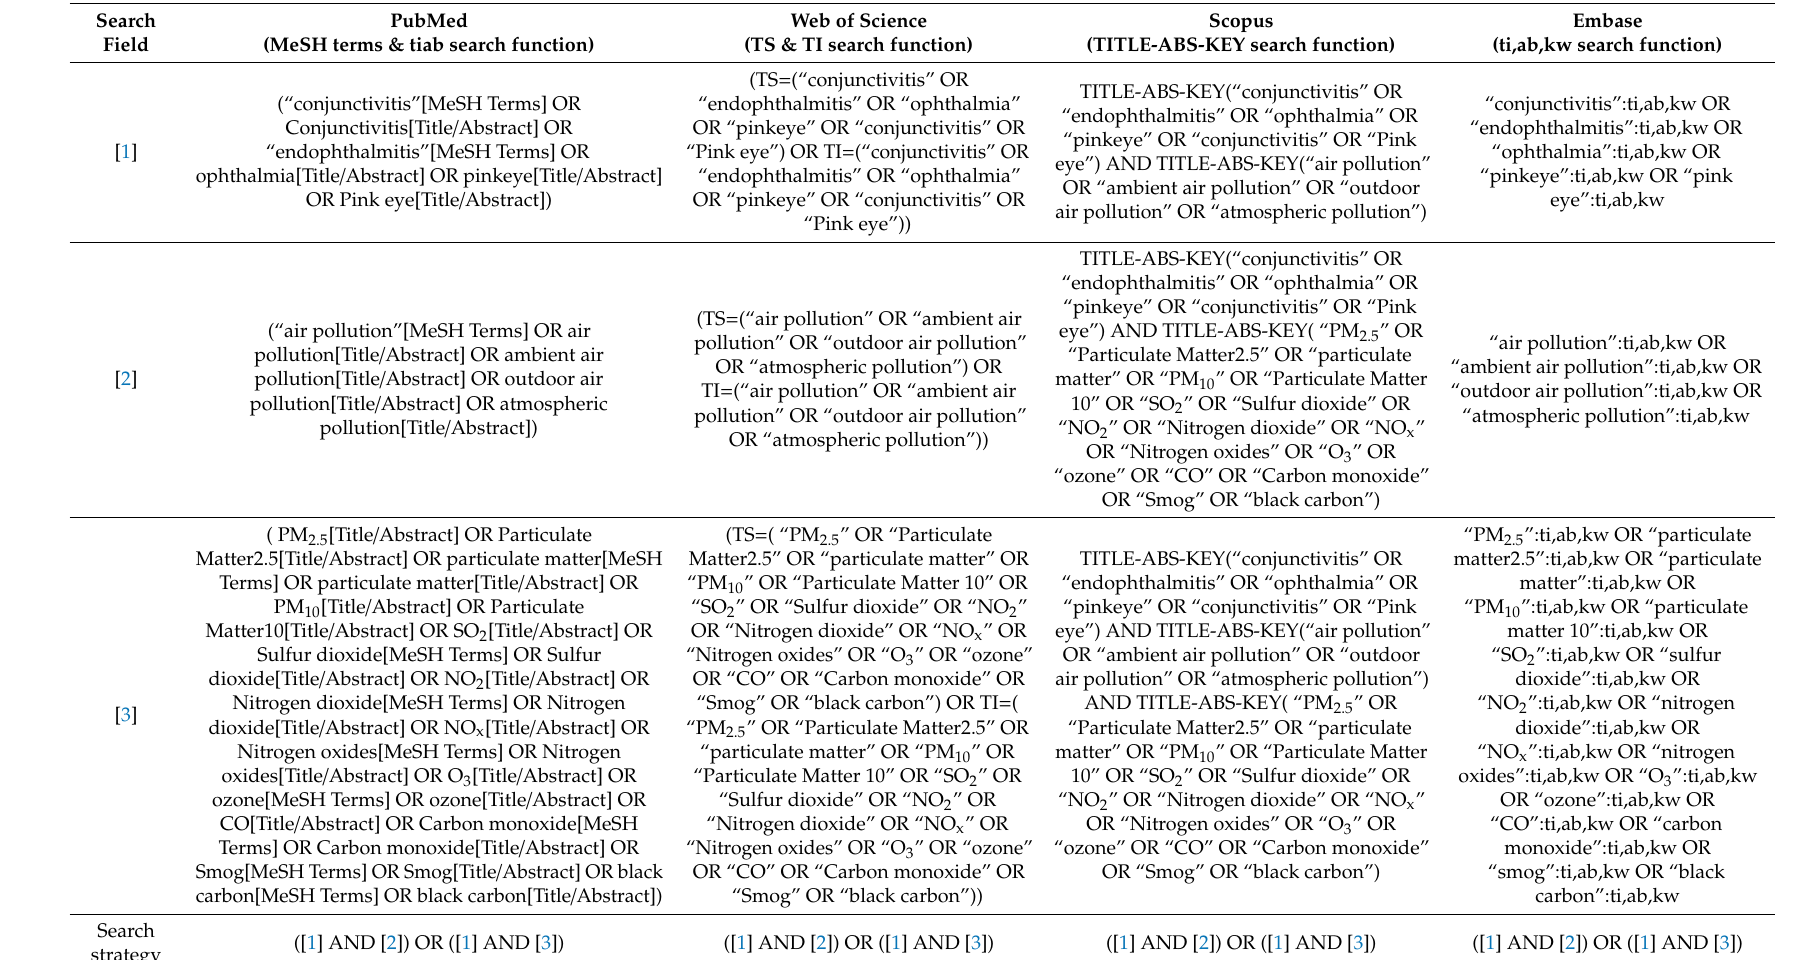
Table A1. The search strategies used in the